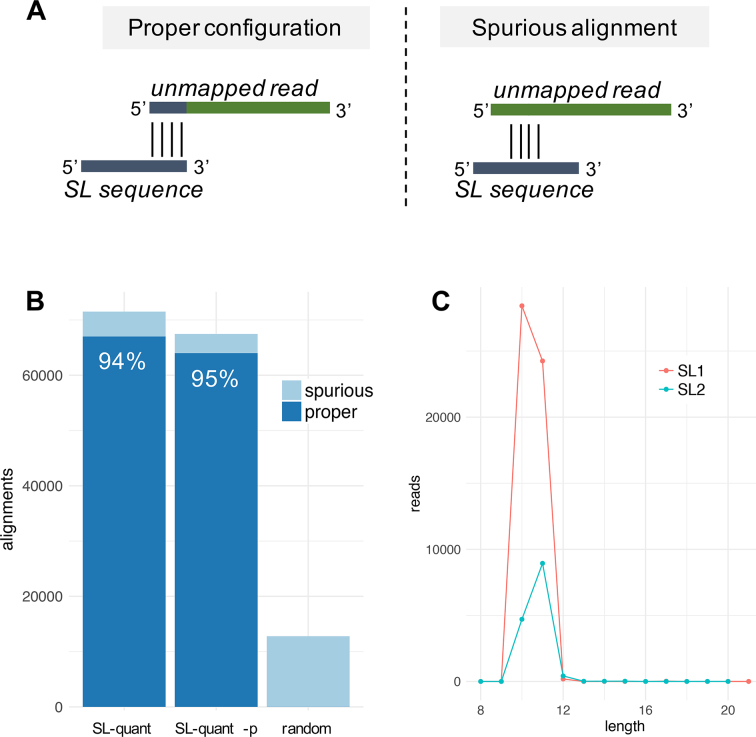
Configuration of the BLAST alignments. (A) InSL-quant, the BLAST alignments are considered as properly configured if starting from the 5’ end of the unmapped read and ending at the 3’ end of the SL sequence. (B) Proportion of properly configured alignments out of the significant alignment identified by SL-quant in single and paired-end (-p) mode on the SRR1585277 dataset, or on 106 random reads in single-end mode. (C) Number of properly configured significant alignments found by SL-quant on the SRR1585277 dataset (single-end mode) by alignment length on the SL1 or SL2 sequences.